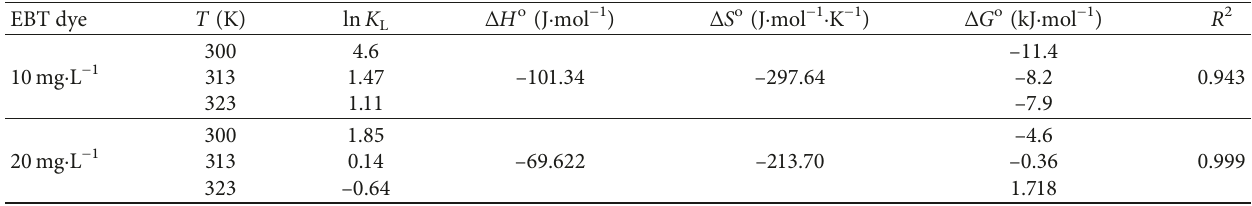
Table 5: Thermal parameters for the adsorption of 10 and 20mg · L − 1 of EBT dye by 0.1g/50mL NSG nanocomposite at a pH of 3. EBT dye T (K) ln K